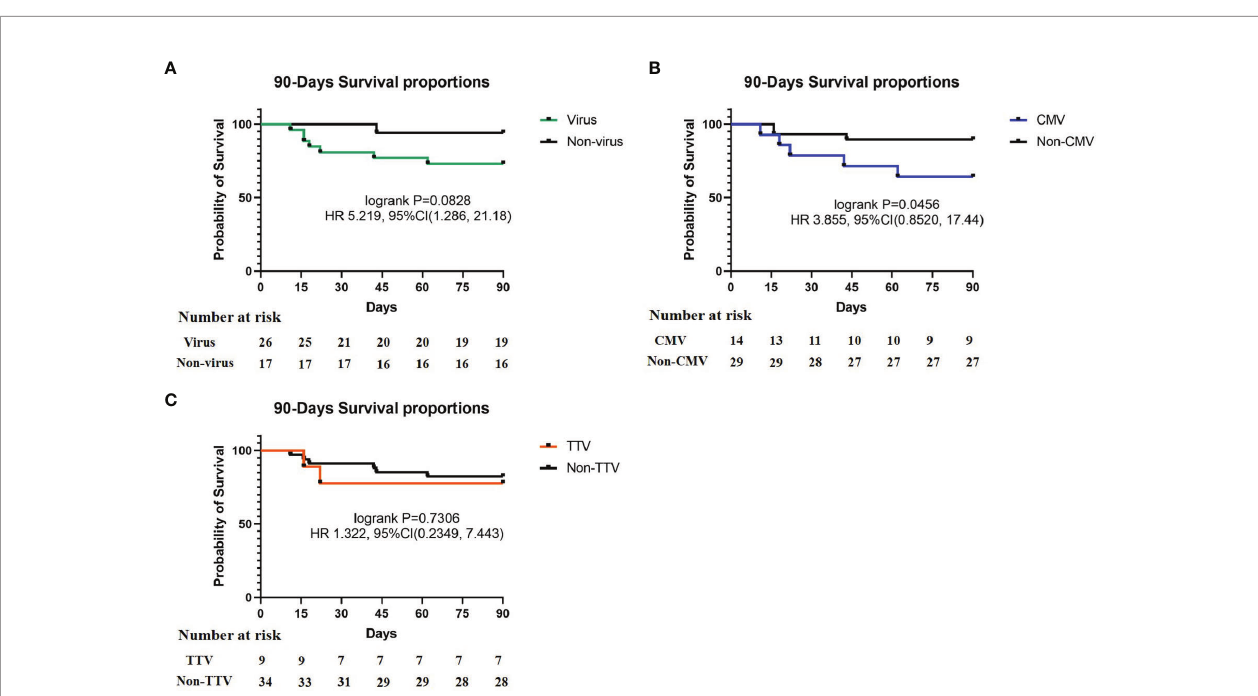
FIGURE 3 | 90-Days Survival proportions of different virus. (A) Survival proportions of virus and non-virus, p = 0.0828; (B) survival proportions of CMV and non- CMV, p = 0.0456; (C) survival proportions of TTV and non-TTV, p = 0.7306. Recipient number is displayed in the Number at